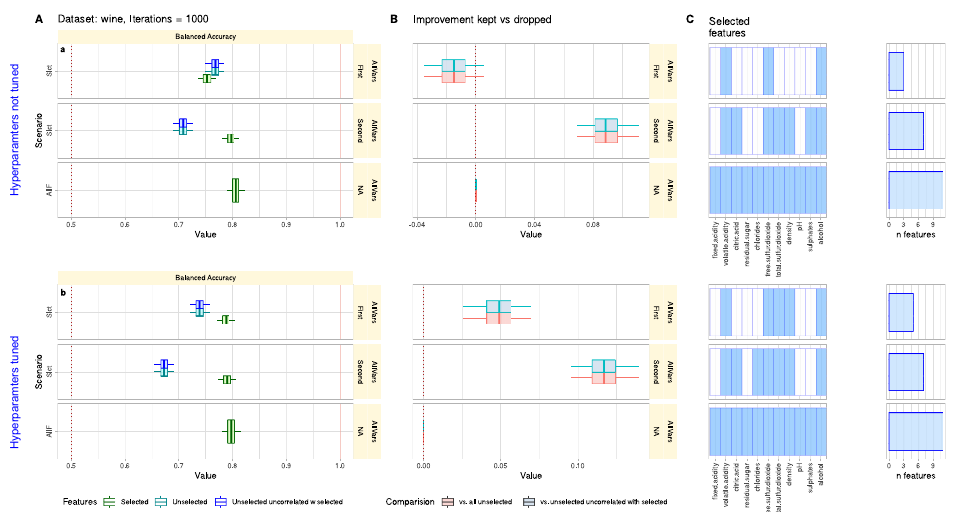
Figure 5. Feature selection and classification performance evaluation with different feature sets in the wine quality data set from https://www.kaggle.com/datasets/shelvigarg/wine-quality- dataset (accessed 2 November 2022). The graph is divided into subgraphs a–b from top to bottom. Experiments were performed ( a ) with non-tuned ( a ) and tuned ( b ) hyperparameters. The two subgraphs show from top to bottom (i) the results when using the features selected in the default feature selection, (ii) the features added when performing a second feature selection on the unselected features from the first selection, and (iii) when training the algorithm with the full feature set. The boxes show the 25th, 50th (blue vertical line), and 75th percentiles of balanced accuracies obtained in 1,000 repeated runs with a random selection of 67% from the training data set and 80% from a validation data set separated from the data set before feature selection. Whiskers span the 95% confidence interval from the 2.5th to the 97.5th percentiles. ( A ): Balanced accuracy obtained with a random forests classifier trained with (i) the selected features, (ii) the unselected features, and (iii) the unselected features that were not highly correlated with the selected features, with the correlation threshold set at a very strong correlation of ρ > 0.9. ( B ): Difference in balanced accuracy when algorithms were trained with the selected versus unselected features. ( C ): Selected features (blue) and unselected features